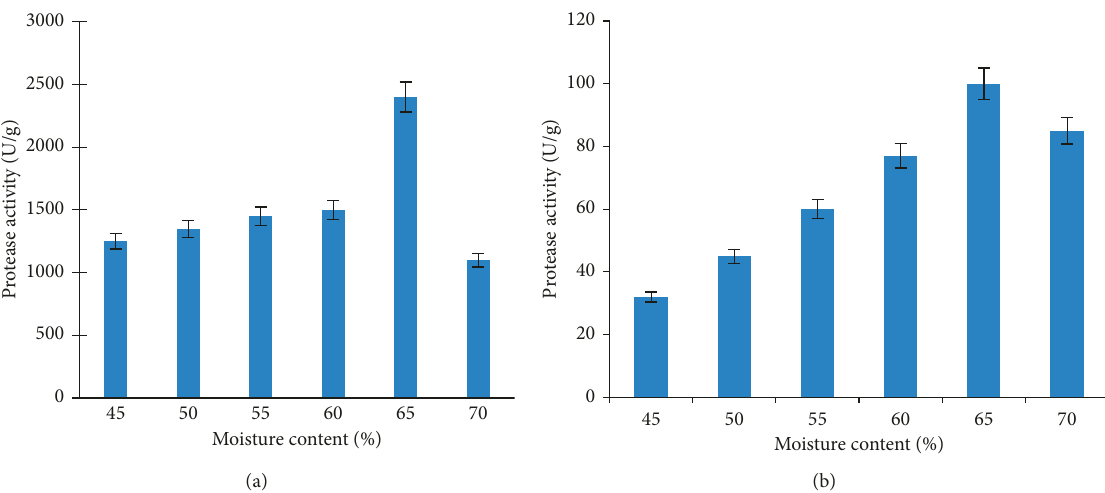
° C for 120h 4 at 30